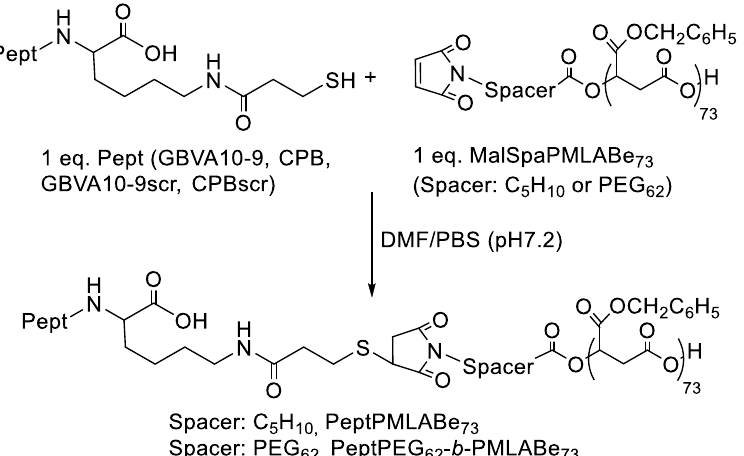
73, and ( B ). CPBPEG 62 - b -PMLABe 73